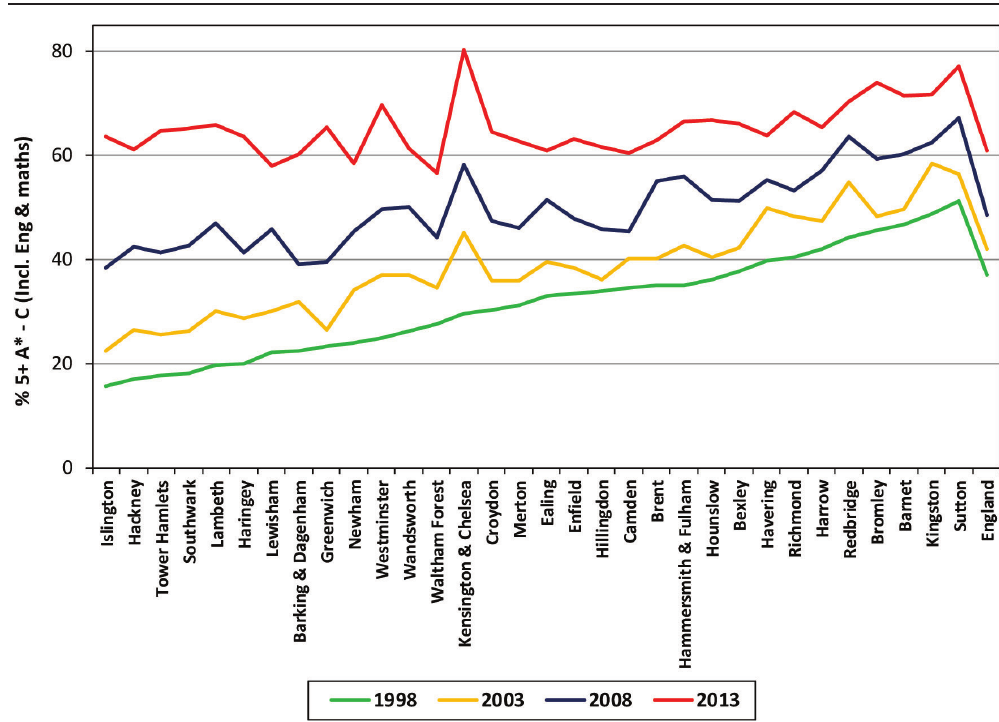
Figure 3: London LAs GCSE performance versus England, percentage 5+ A*–C including English and mathematics in 1998, 2003, 2008 and 2013